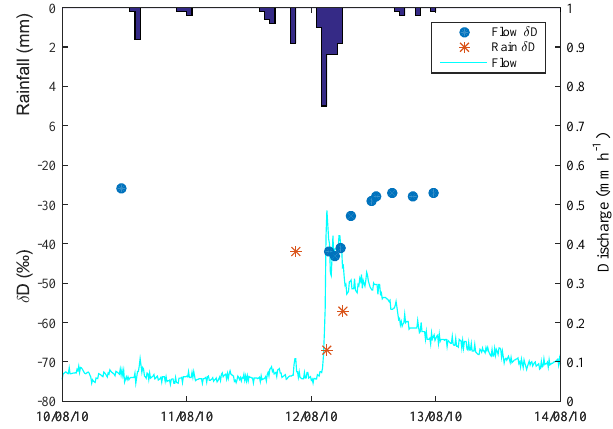
Figure 9. Time series of total rainfall and discharge, 2 H of rainfall and runoff for the event on 12 August